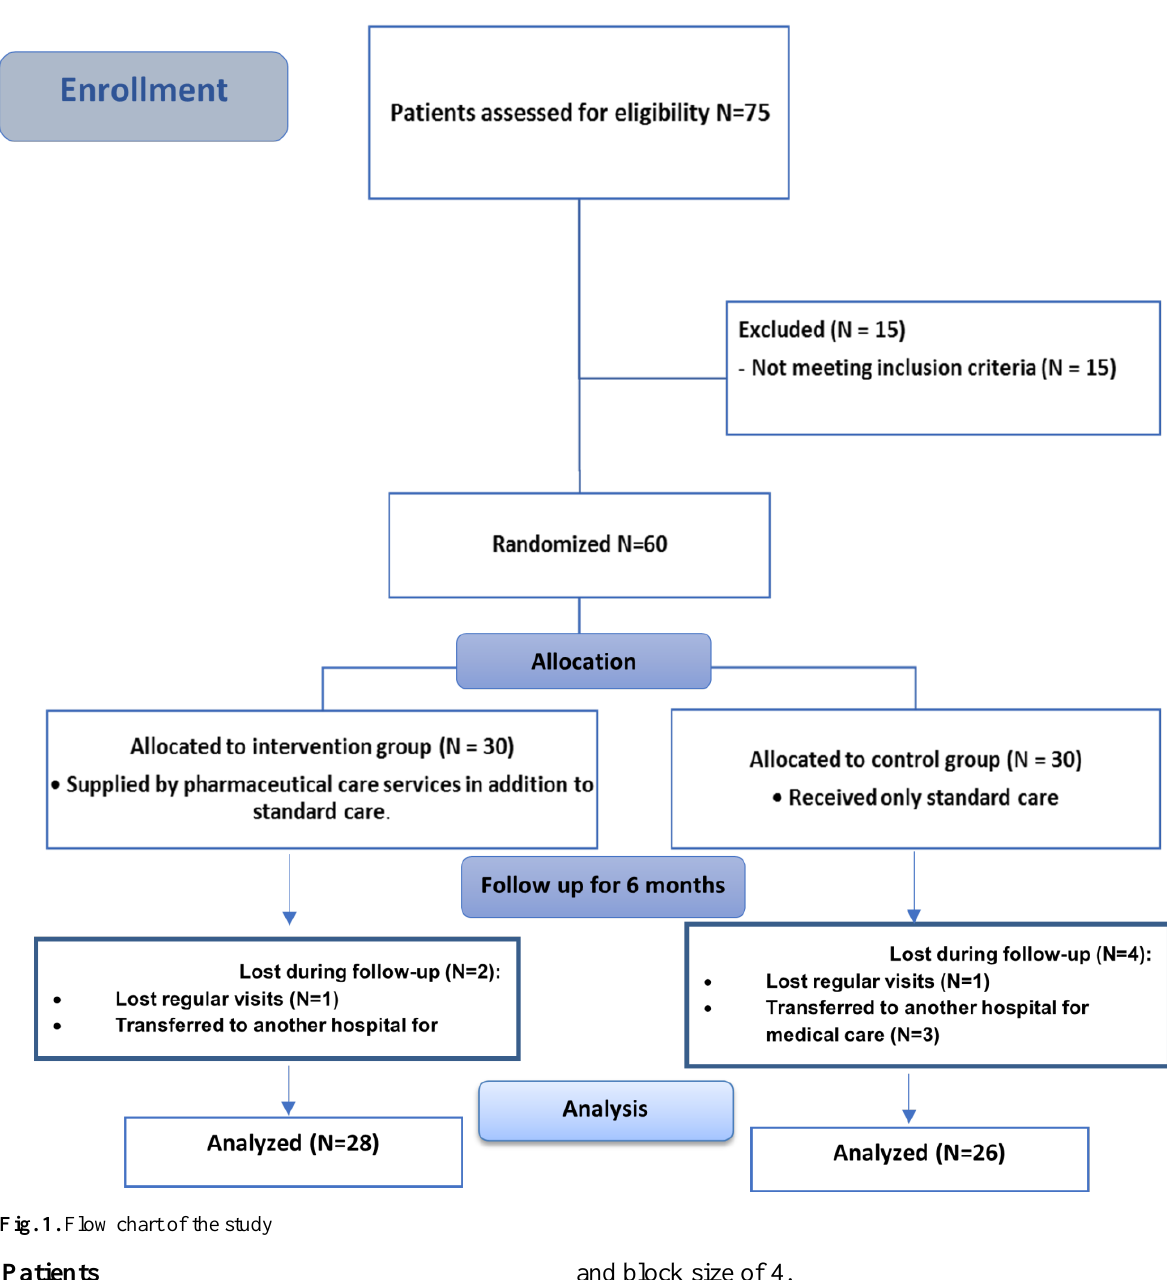
Fig. 1. Flow chart of the